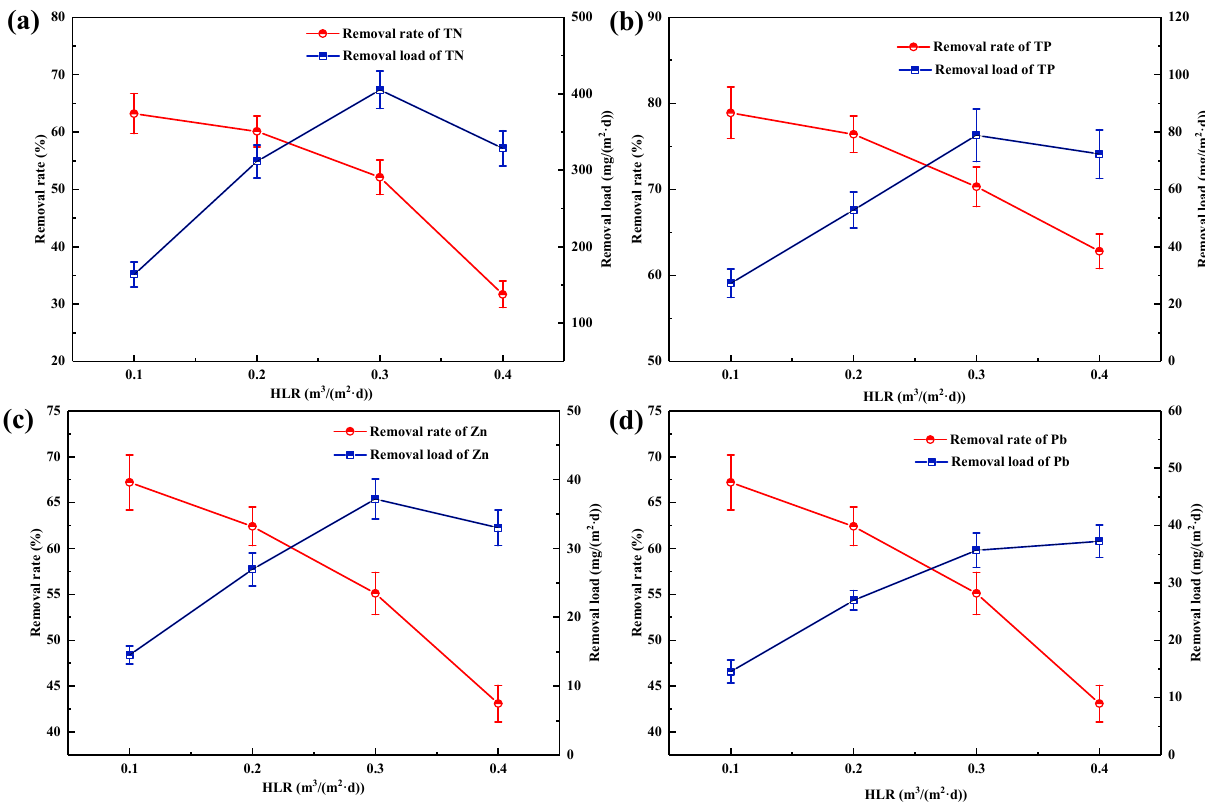
Figure 2. The influence of hydraulic loading on pollutant removal (mean ± standard deviation).